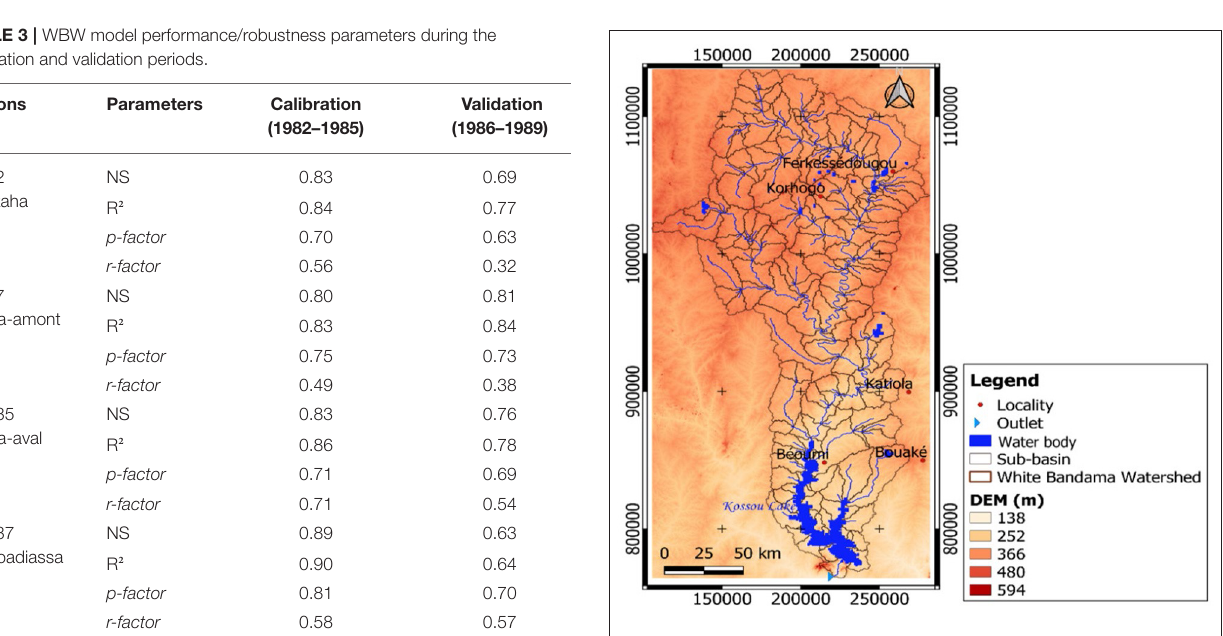
capacity of ∼ 538.56 MW. Figure 12 shows these potential sites for future hydropower deployment and their geospatial location in the